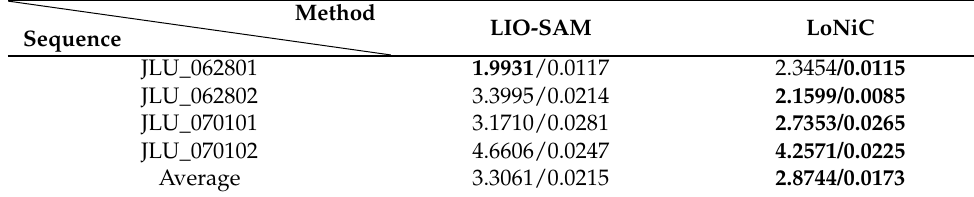
Table 5. Relative pose error of LIO-SAM and LoNiC on the JLU campus dataset. Sequence